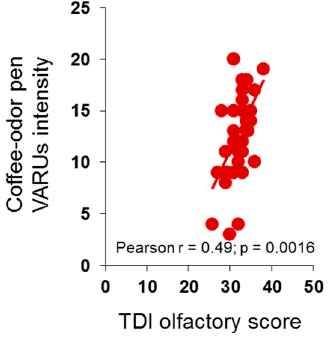
Figure 6. Correlation analysis between the intensity perceived for the coffee-odor pen by each subject